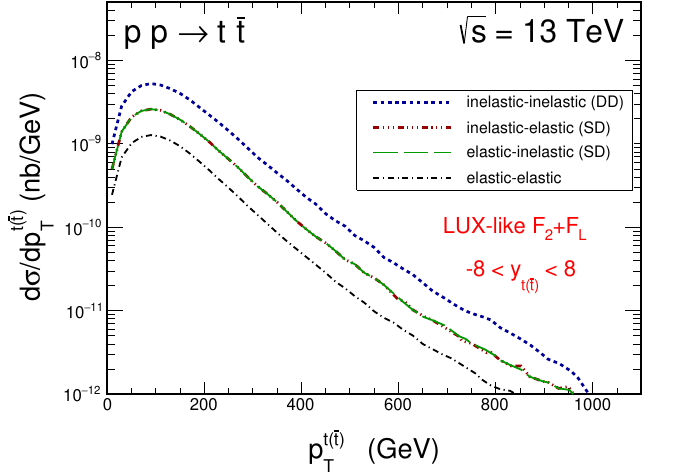
Figure 3 . Transverse momentum distribution of t or (cid:22) t for di(cid:11)erent components de(cid:12)ned in the